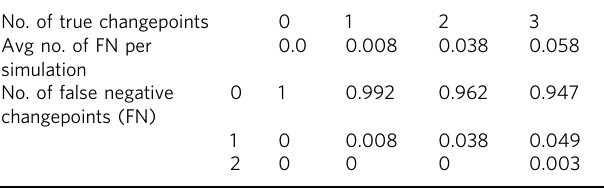
Table 1 False negatives rates in non-parametric simulations.